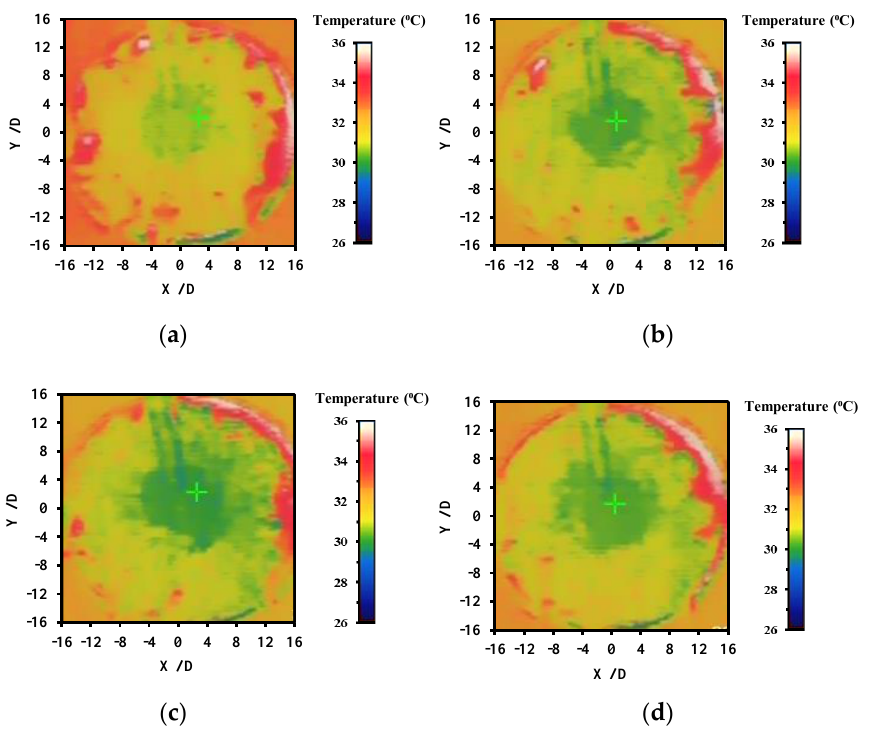
Figure 19. Thermography images of SIJ at ( a ) H/D = 1, ( b ) H/D = 2. ( c ) H/D = 3, and ( d ) H/D = 4.